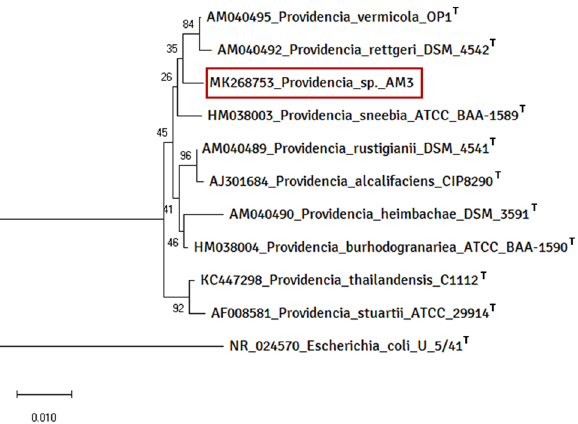
Figure 2. Phylogenetic tree of strain Providencia sp. nov. AM3 including all nine member species of Providencia genus. Escherichia coli serves as an outgroup. T , Type species (image created in MEGA X) 17